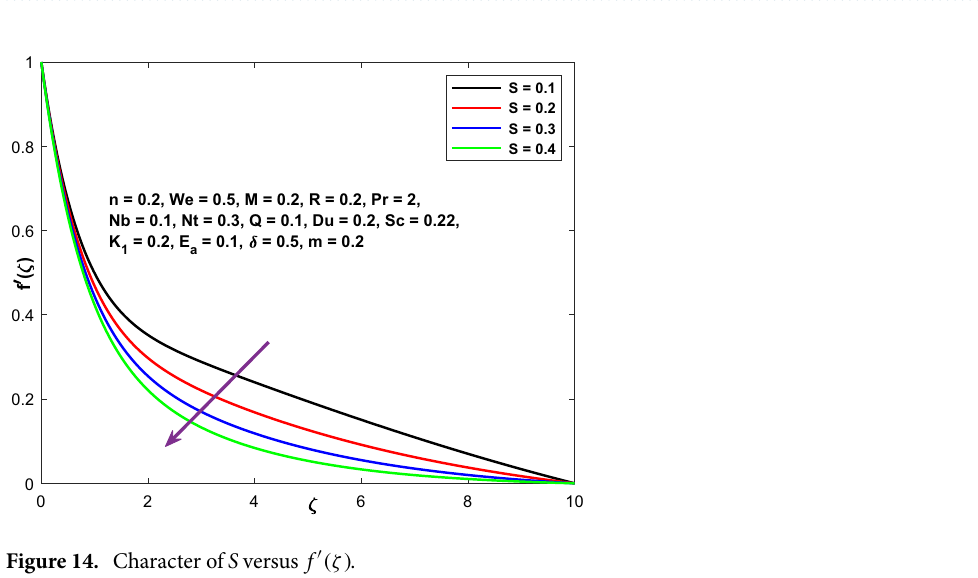
Figure 14. Character of S versus f ′ (ζ)